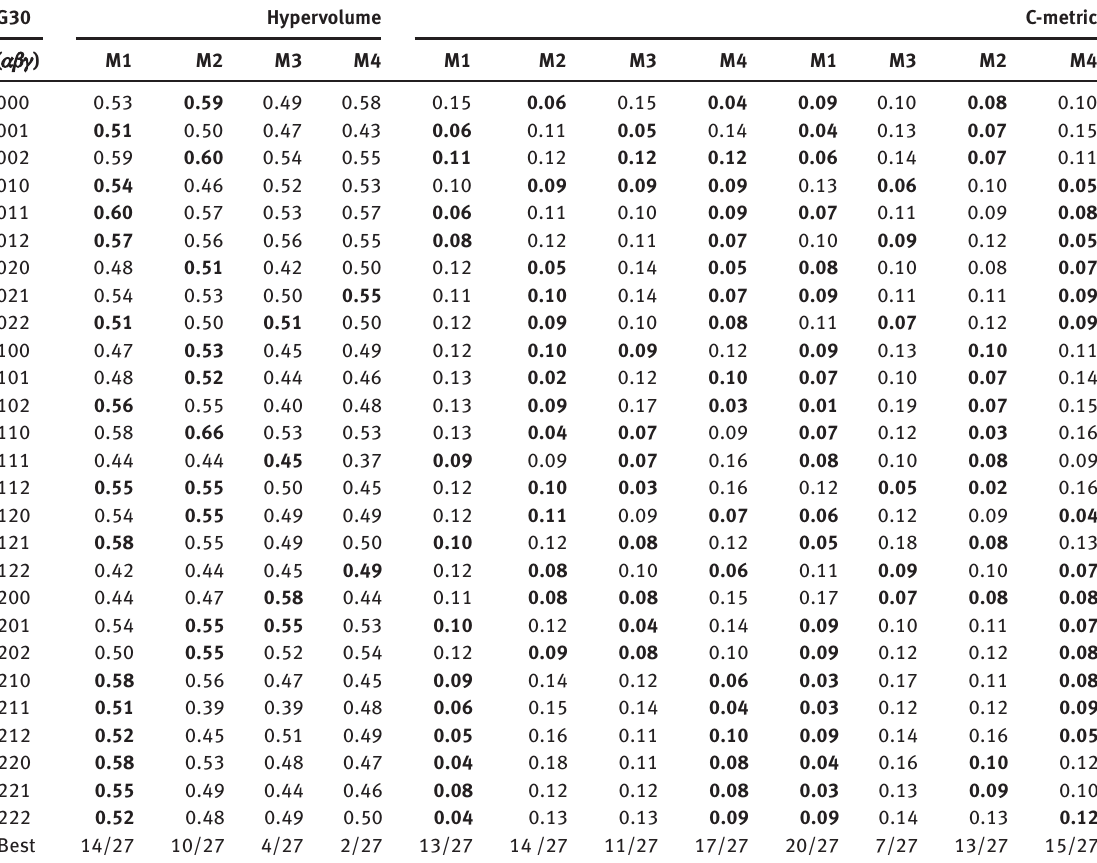
Table 4: G 30 – Hypervolume and